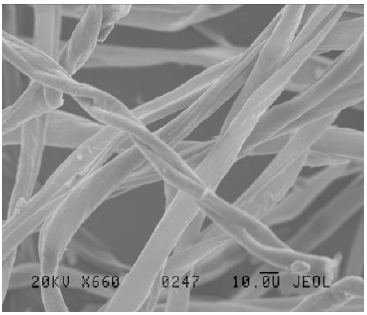
Figure 5. Exemplary microscopic picture of cotton fibers.